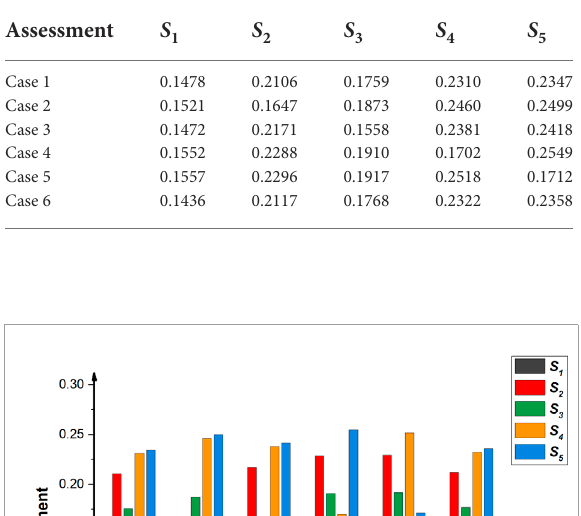
TABLE 16 Assessment results under six cases of defuzzified component B ′ .